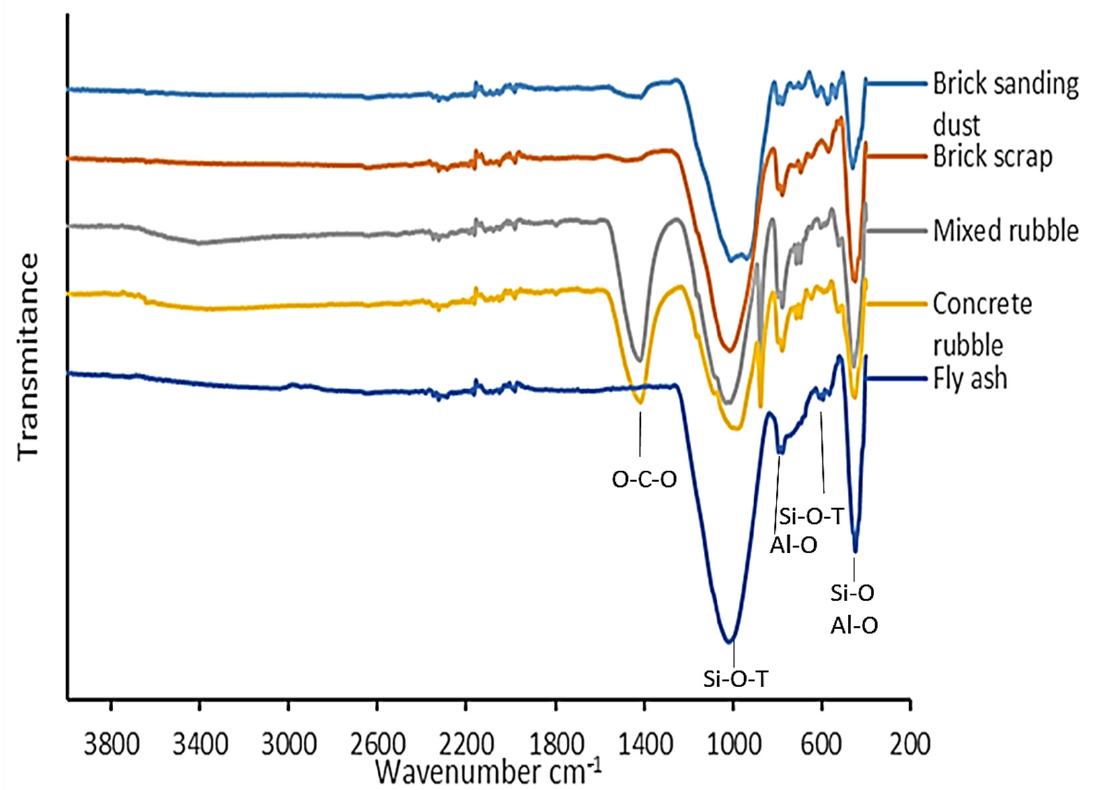
Figure 4. Infrared transmission spectra of the input materials: brick sanding dust, brick scrap, mixed rubble, concrete rubble, and fly ash.